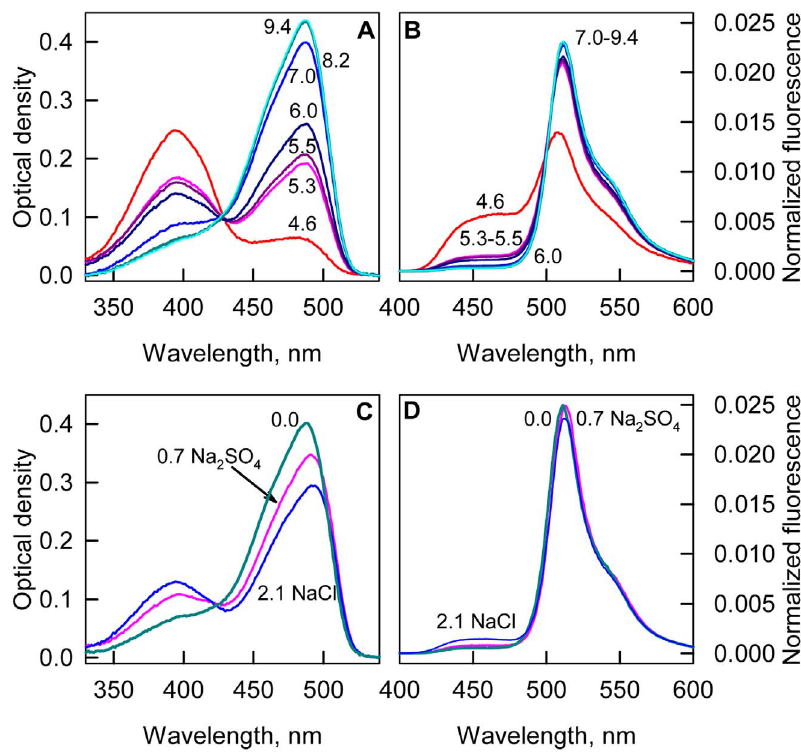
Figure 4. The effect of pH and ionic strength on sfGFP spectroscopic characteristics. Absorption spectra ( A ) and fluorescence spectra ( B ) of sfGFP in the solutions with different pH. Fluorescence was excited at 390 nm and normalized to total fluorescence at current pH value. The numbers on panels A and B are the values of pH in solution. Absorption spectra ( C ) and fluorescence spectra ( D ) of sfGFP in the buffered solution and in solutions with the equal ionic strength but containing 0.7 M Na 2 SO 4 or 2.1 M NaCl. Fluorescence was excited at 390 nm and normalized in the same manner as data on panel B.